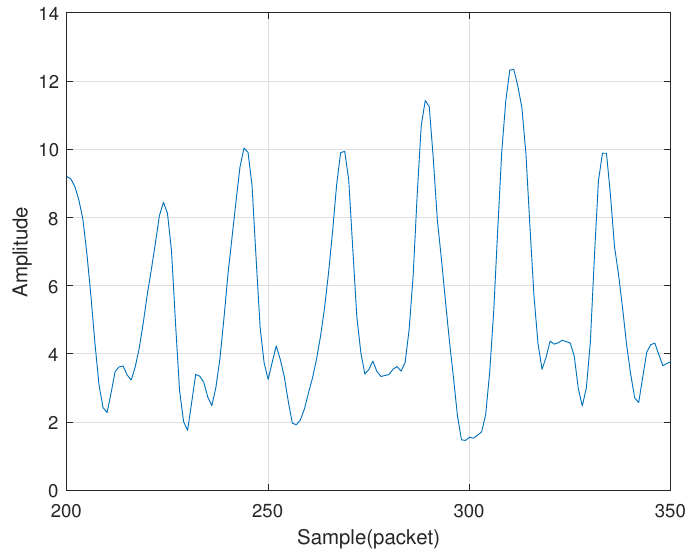
Figure 2. Rapid changes in amplitude.